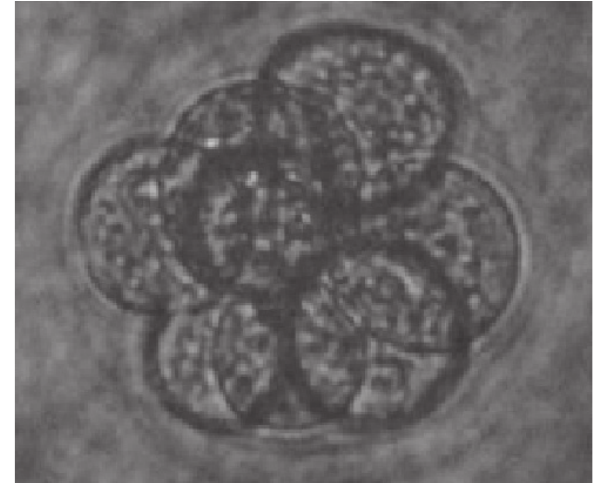
Figura 2. Embrião exposto aos vírus (Grupo G após 24 h de incubação. Aumento do espaço periplasmático (seta em vermelho) (100x, 5,7x zoom).